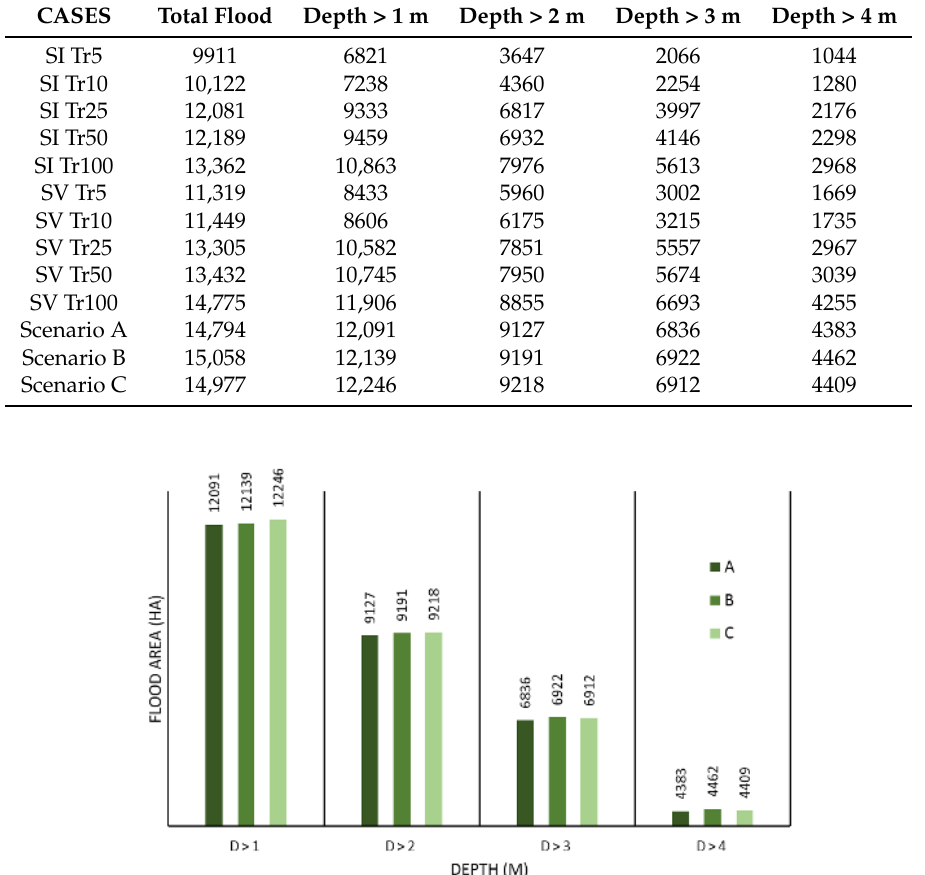
Table 7. Flood areas in hectares.